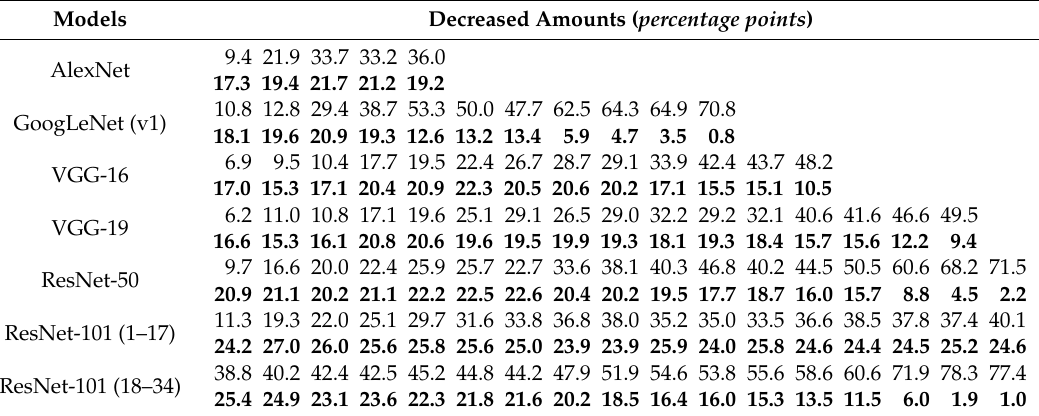
Table 1. Decreased amounts of true and false positives when applying the distance threshold.